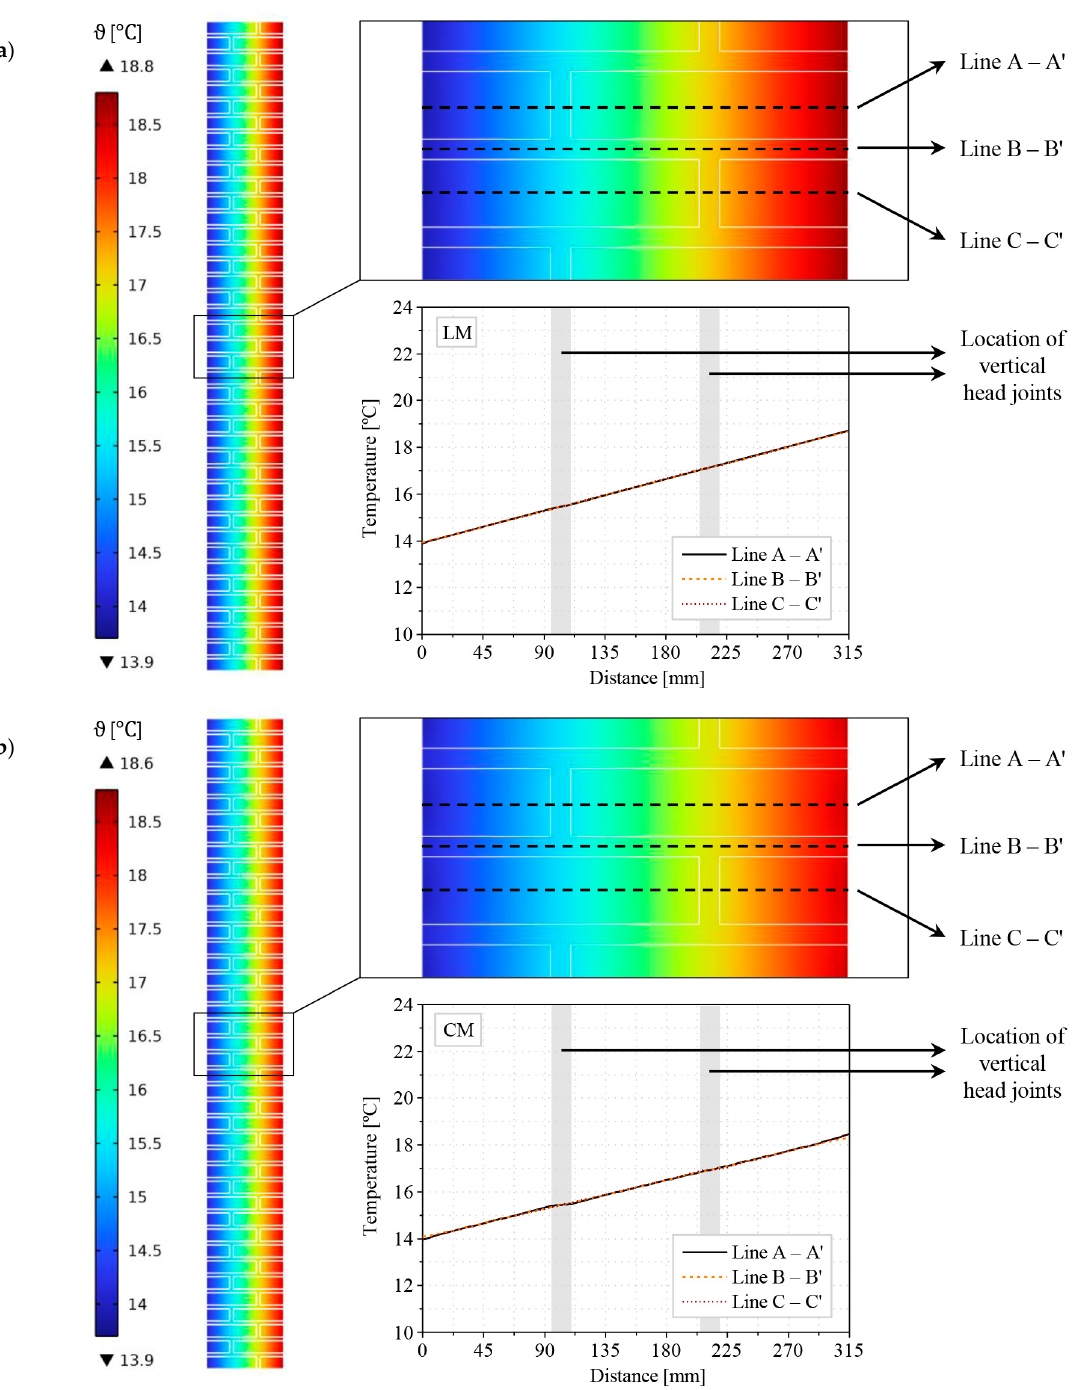
Figure 3. Steady-state analysis (SS). Temperature distribution across the studied three-wythe brick masonry wall: ( a ) joints with lime mortar (LM); ( b ) joints with cement mortar (CM).